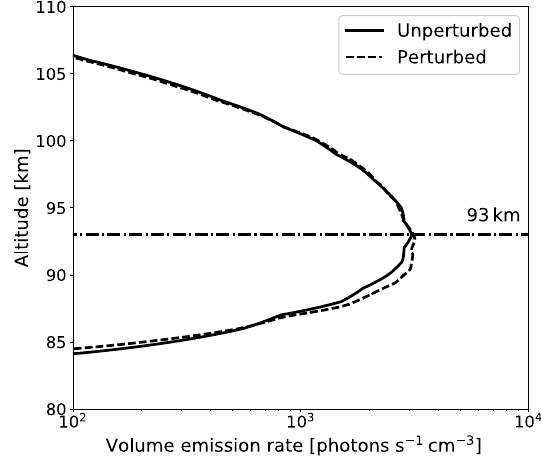
Figure 4. Temperature dependence of six rotational lines of the O 2 A band. The line centre wavenumbers for the lines are given in the figure legend. The intensity is normalized around the maximum in- tensity for a temperature of